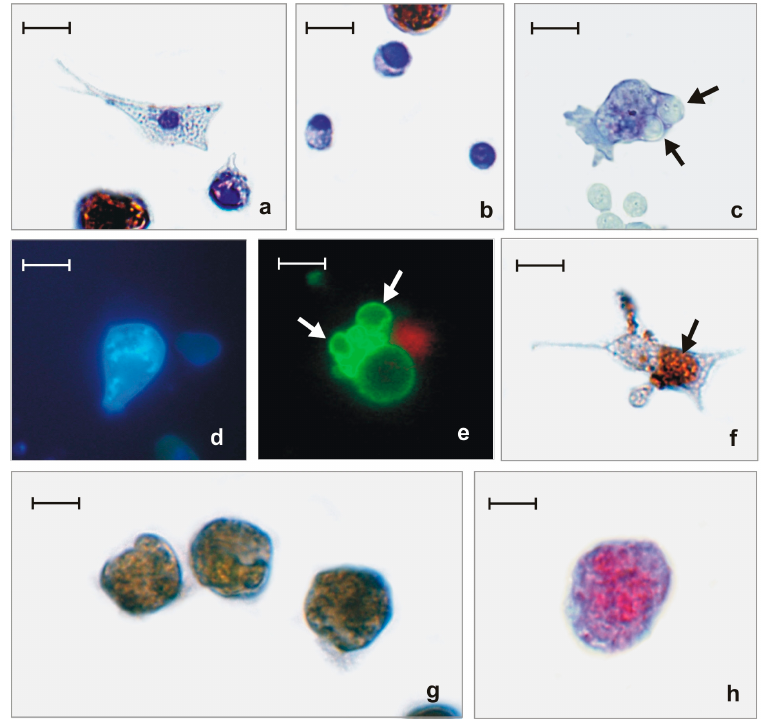
Figure 2. Haemocytes of Botryllus schlosseri . ( a ) Glutaraldehyde-fixed phagocyte stained with Giemsa dye showing long pseudopodia. ( b ) Three cells of the same type after exposure to 0.1 μ M (33.3 μ g/l) dichlofluanid. Note the cell shrinkage and the roundish shape due to the loss of pseudopodia, indicating damage to both the pump proteins and cytoskeleton, respectively. ( c ) Fixed large phagocyte stained with Giemsa dye showing yeast cells engulfed inside phagosomes ( arrows ) after the phagocytosis assay; a cluster of yeast cells is present below. ( d ) Untreated living phagocyte containing GSH in the cytoplasm. ( e ) Living phagocyte positive to the annexin-V reaction after exposure to 0.05 μ M (16.6 μ g/ml) dichlofluanid. Note the cytoplasmic protrusions, namely, blebs, which are a typical feature of early apoptosis ( arrows ). ( f ) Glutaraldehyde-fixed phagocyte positive to the TUNEL reaction after exposure to 0.05 μ M (16.6 μ g/ml) dichlofluanid. Note the brown labelled nucleus typical of late apoptosis with DNA fragmentation ( arrow ). ( g ) Glutaraldehyde-fixed cytotoxic cells (morula cells) positive for phenoloxidase activity. ( h ) Glutaraldehyde-fixed large phagocyte with vacuoles positive for acid phosphatase. Bar length: 5 μ m in ( a , b ); 3.5 μ m in ( c ); 10.5 μ m in ( d ); 11.5 μ m in ( e ); 7 μ m in ( f ); 4 μ m in ( g ); and 3 μ m in ( h ).